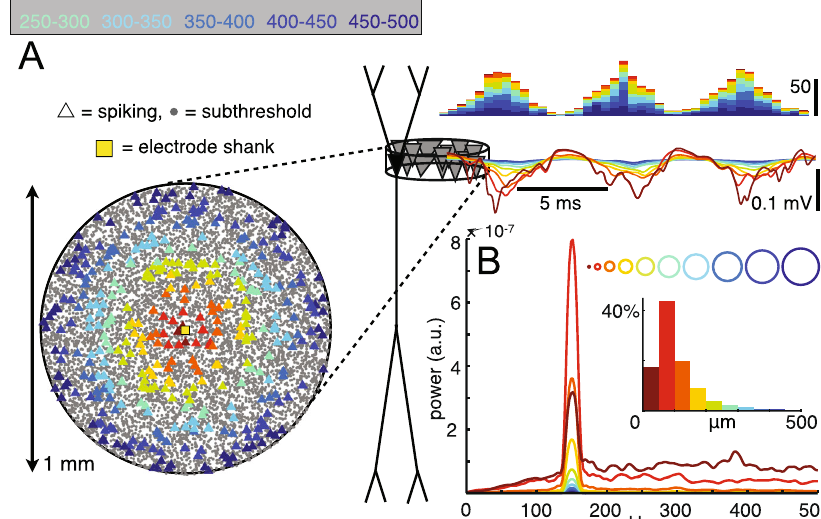
Fig. 2 | Spikes from groups of distant neurons contribute substantially to fast LFP oscillations. A Histograms of extracellular spikes (top right) extracellular voltages along the CA1 stratum oriens – stratum radiatum axis in a rhythmically bursting population with ~6% of the population fi ring in each 10ms interval. Spike bursts recur periodically at 150Hz and have a Gaussian shape. The locations of neurons that spike during one 6.7ms ripple period are indicated by triangles in a top-down view of the pyramidal layer (left), with colors indicating the 50 µ m-wide ring from which the spikes originate. Voltage traces are colored correspondingly,